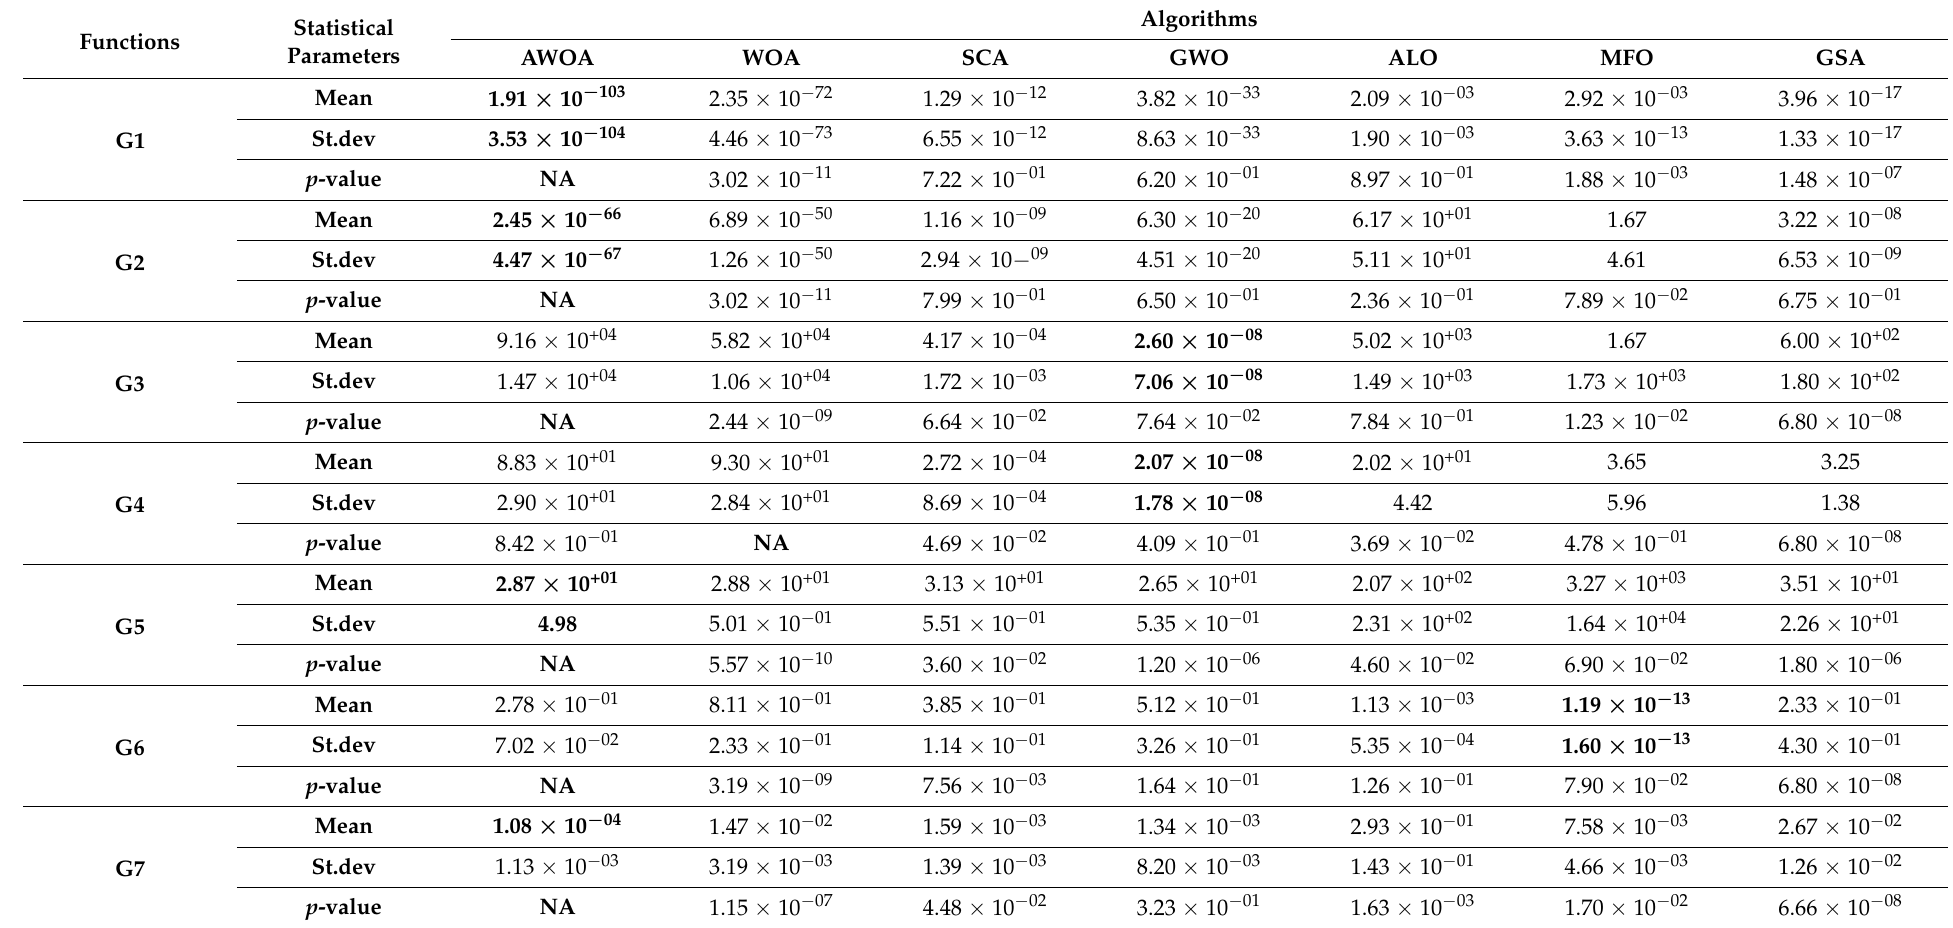
Table 5. Average, Standard Deviation, and p -Value of AWOA and other comparable algorithms for Uni-modal